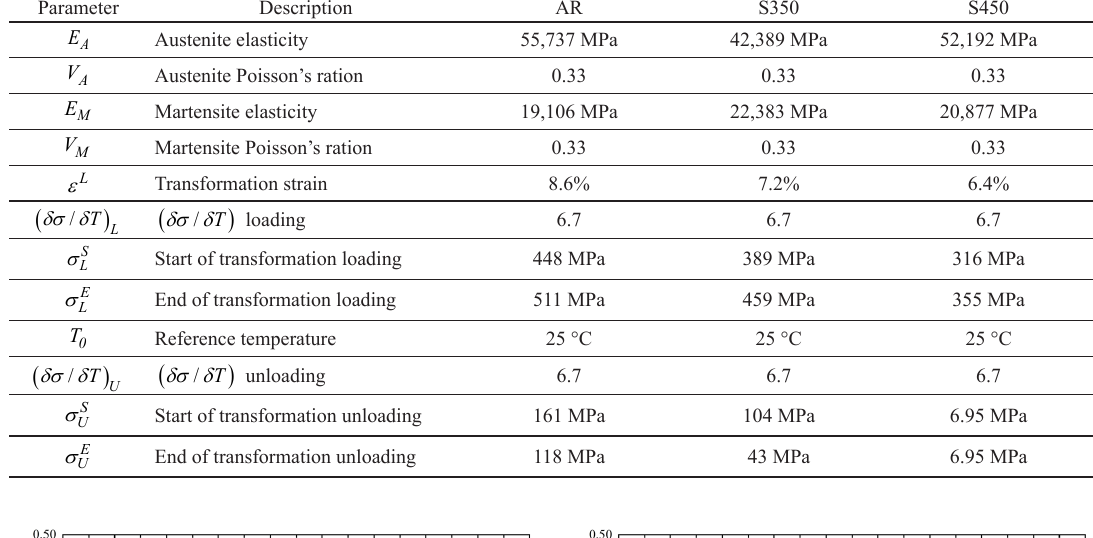
Table 1. Parameters used to describe the constitutive model for simulation. Parameter